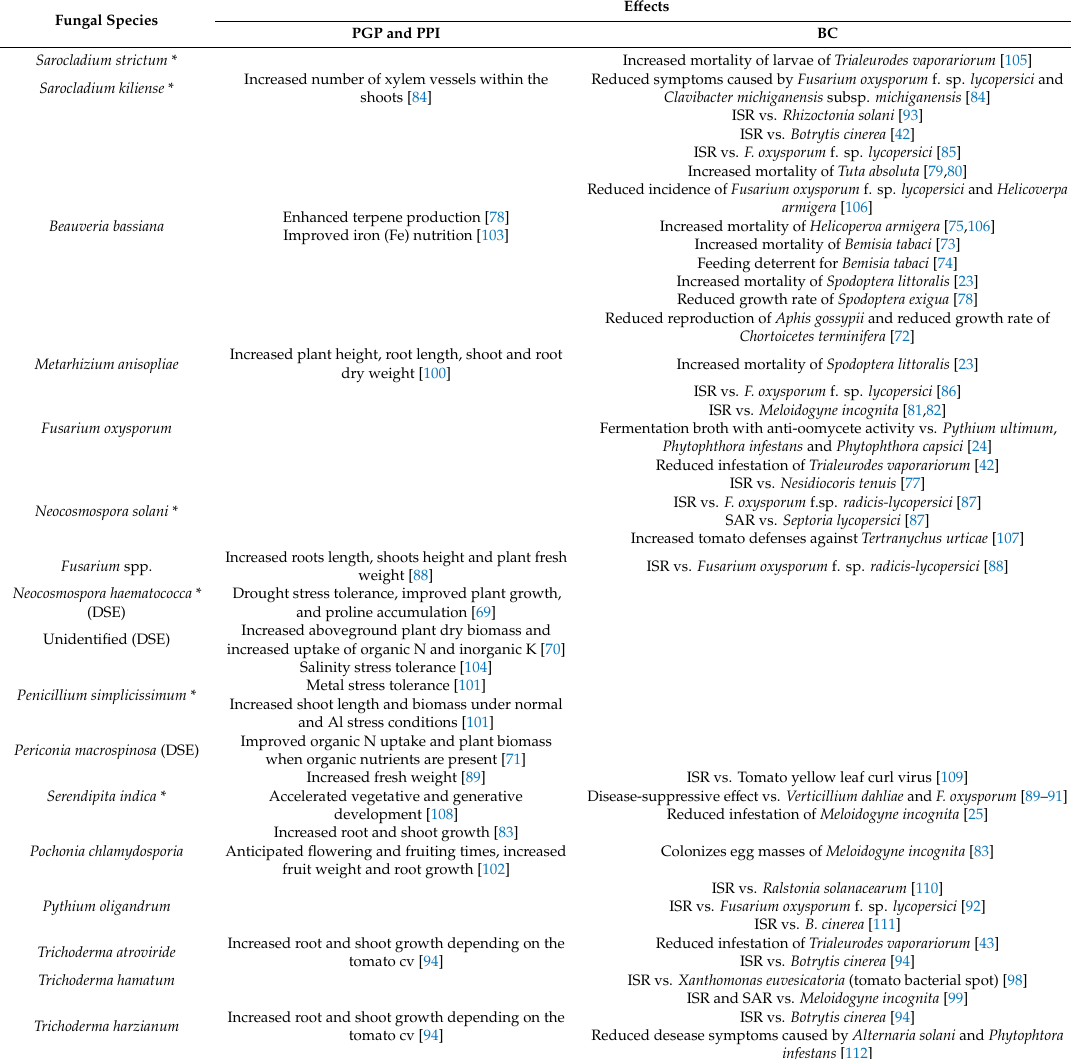
Table 1. E ff ects of introduced fungal endophytes on tomato plants in terms of Plant Growth Promotion (PGP) and Plant Physiology Improvement (PPI), and Biocontrol (BC) of pest and pathogens. E ff ects Fungal Species PGP and PPI BC Sarocladium strictum * Increased mortality of larvaeof Trialeurodes vaporariorum [105] Sarocladium kiliense * Increased number of xylem vessels within the shoots [84] Reduced symptoms caused by Fusarium oxysporum f. sp. lycopersici and Clavibacter michiganensis subsp. michiganensis [84]